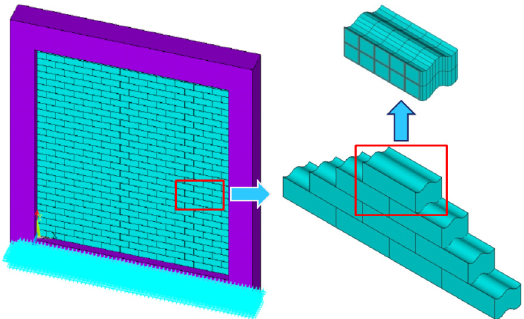
Figure 1. Reinforcement concrete frame with a mortarless brick (MB) panel.